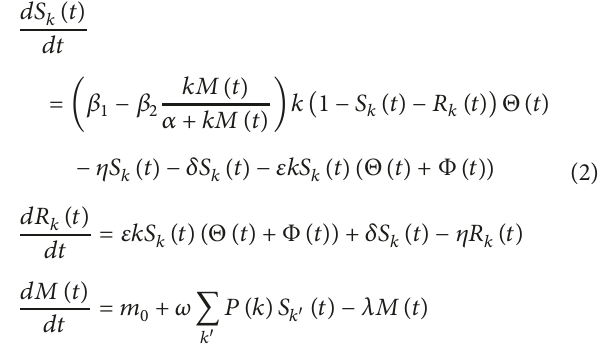
𝛿 : emergency efficiency, by means of isolation and other compulsory administrative measures, the gov- ernment loses the spreading ability of rumor spread-